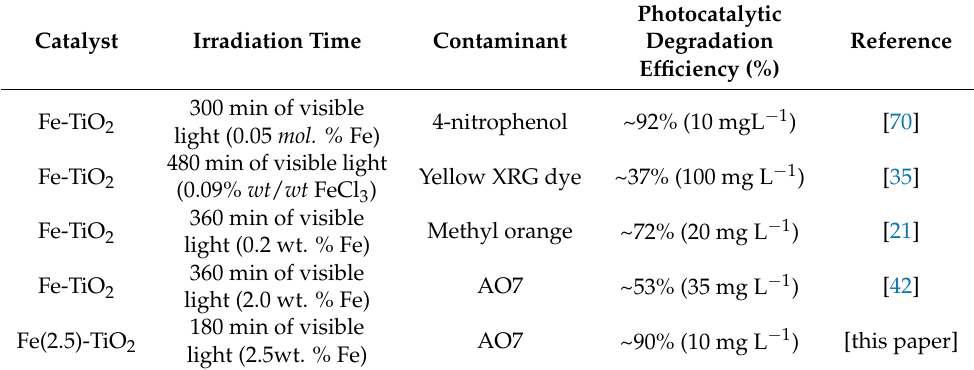
Table 4. Comparison on the photocatalytic activity of the Fe(2.5) -TiO 2 sample under visible light irradiation with the available